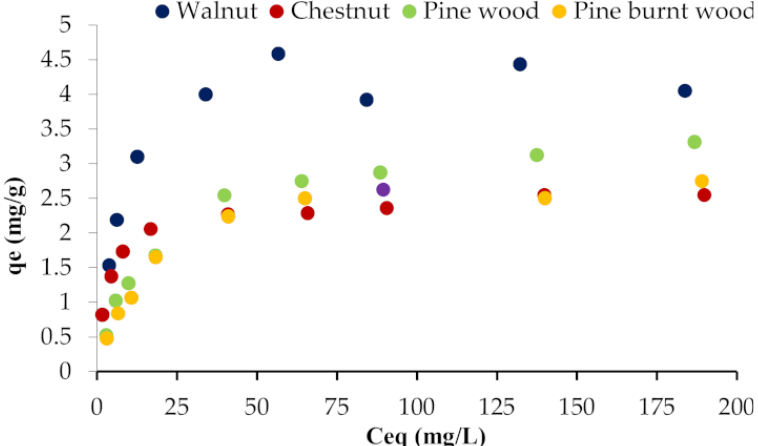
Figure 7. Adsorption isotherms of nickel for walnut shell, chestnut shell, pine wood and burnt pine wood with nickel concentrations from 5 to 200 mg L − 1 and 100 mg of